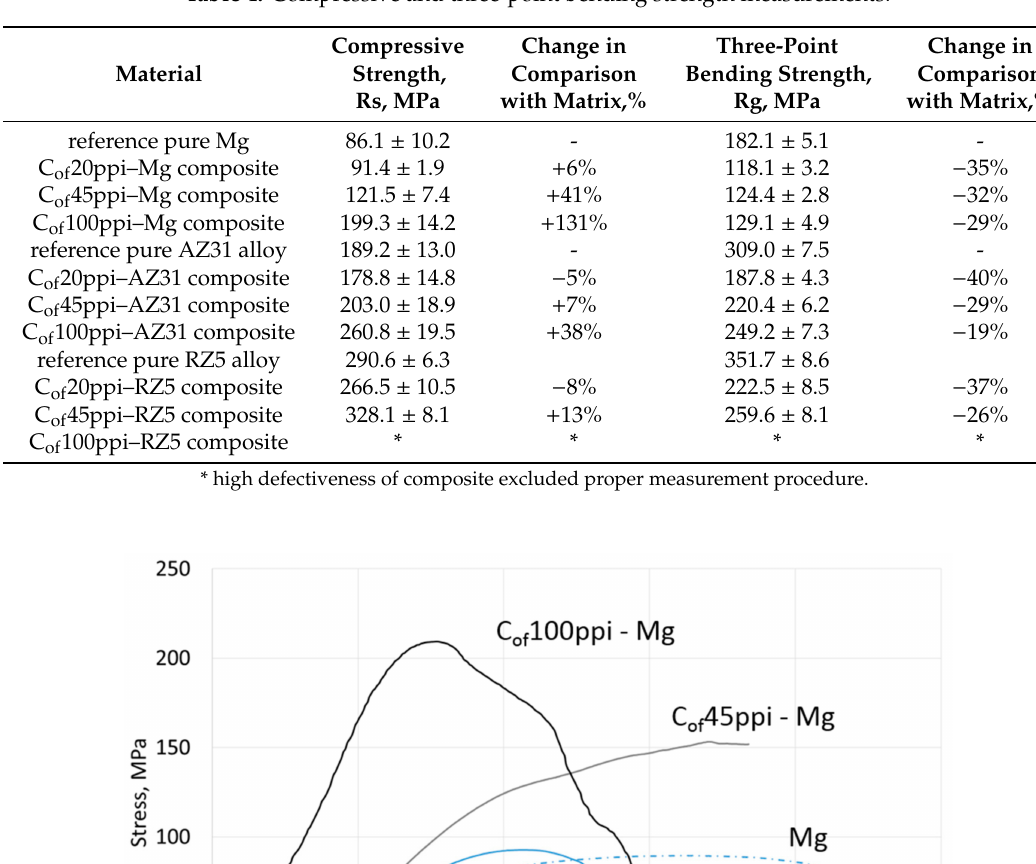
Table 4. Compressive and three-point bending strength measurements.